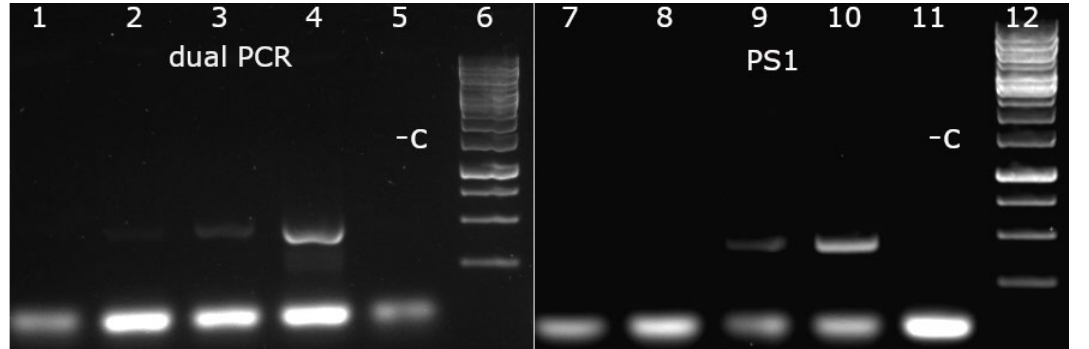
Figure 8. Comparison of 27a sensitivity of dual and 27a-specific PCRs. Lane 1 and 7, 0.55 × 10 4 ; lane 2 and 8, 1.66 × 10 4 ; lane 3 and 9, 4 × 10 4 ; lane 4 and 10, 1.2 × 10 5 copy/reaction 27a DNA respectively; lane 5 and 11, negative control; lane 6 and 12 Gene ruler 1 kb.